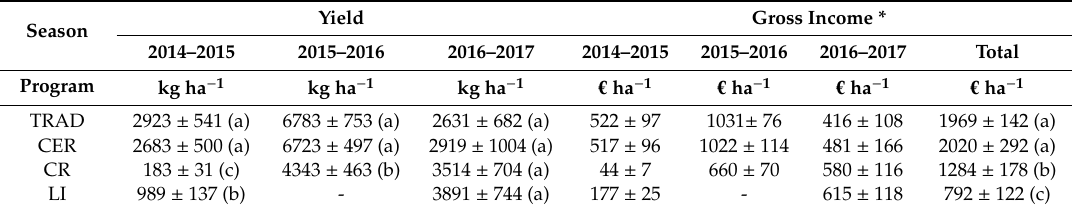
Table 3. Yield (kg ha − 1 ) and Gross income ( € ha − 1 ) ( + SE) obtained each season for each established management program. The result of the statistical analysis for the overall income after three years of each program is included in the last